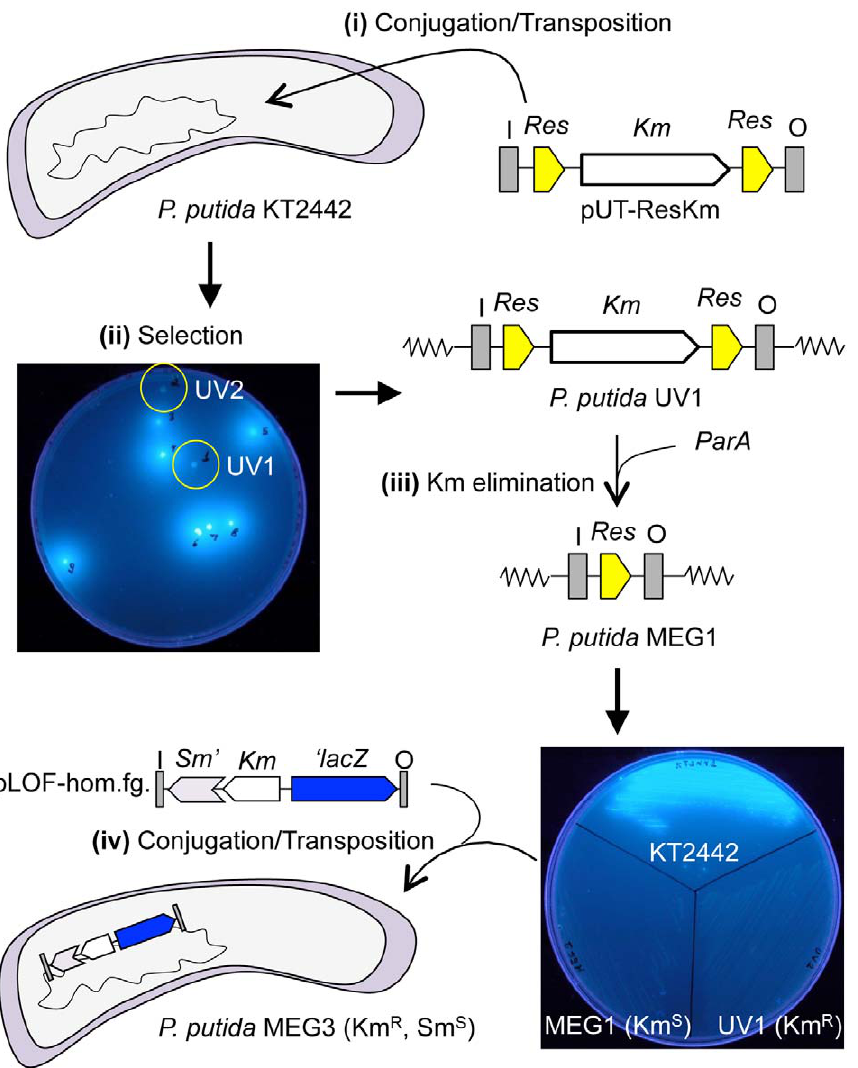
Figure 2. Isolation of a non-fluorescent P.putida strain. (i) P. putida KT2442, a rifampicin resistance variant of P. putida KT2440, was mutagenized with mini-Tn5 transposon pUT-ResKm. (ii) Single colonies were selected in minimal media and screened for the lack of fluorescence. Two colonies were selected and named P. putida UV1 and UV2. (iii) The Km resistance marker was removed from the strains by expressing ParA resolvase, which recognizes the two res sites flanking the Km marker. After marker elimination, the strains retained the non-fluorescence